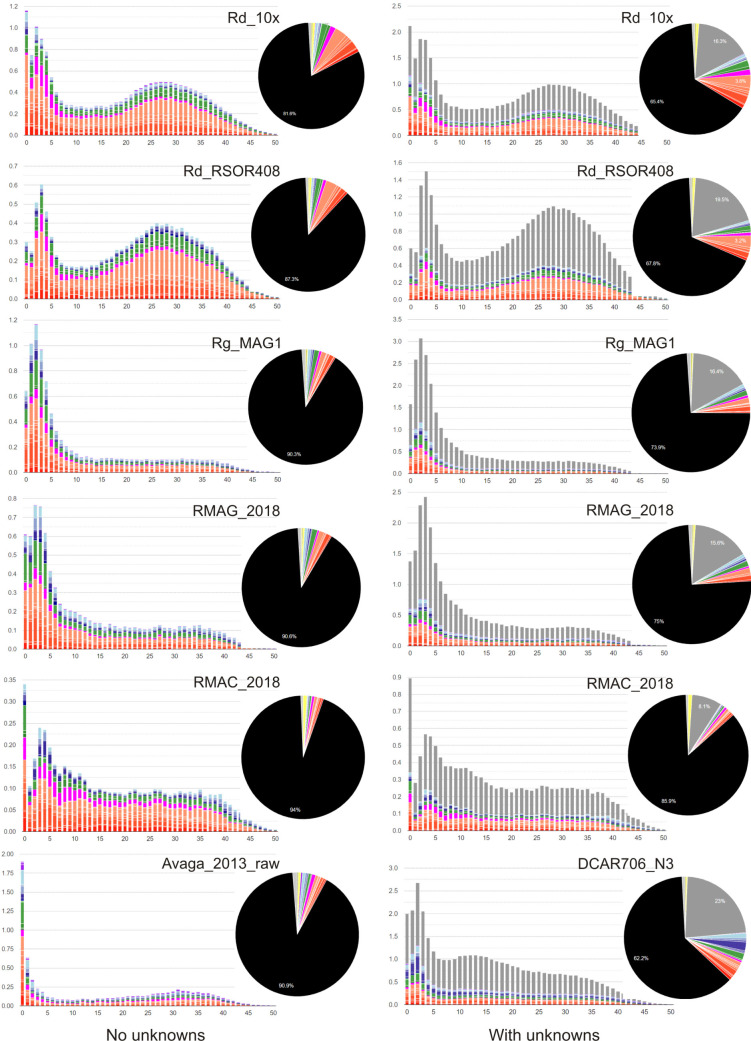
TE divergence landscapes for selected species constructed using REPET (unfiltered, with default parameters).Landscapes and axes are arranged as previously. Pie charts show TE superfamilies occupying ≥2% of a given genome. Colour scheme from RepeatMasker v.4.1.0: orange, cut-and-paste DNA TEs; magenta, rolling-circle DNA TEs; green, LTR-Rs; dark blue, LINEs; light blue, PLEs; yellow, simple repeats; grey, unknown (unclassified). Note a greater proportion of repeats at lower divergence values (K-distance <5).